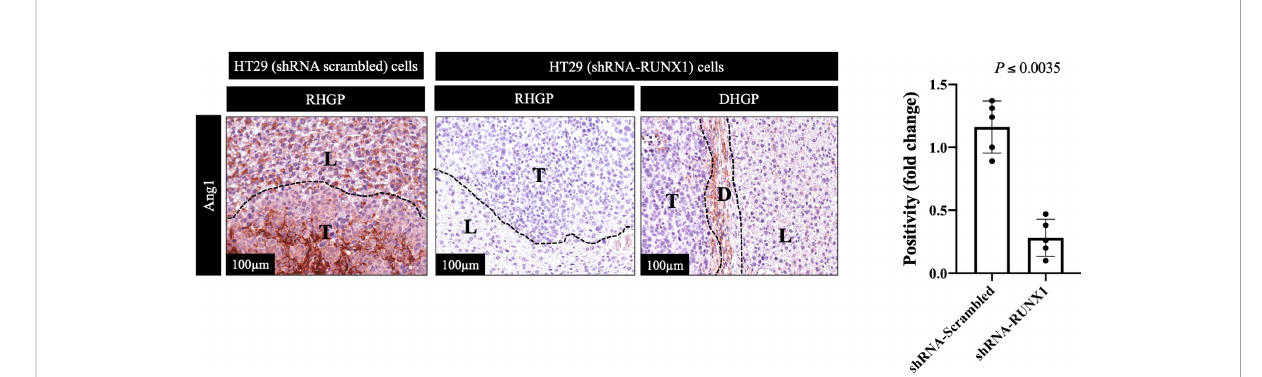
FIGURE 3 Knockdown of RUNX1 in the cancer cells attenuates the expression of Ang1 in liver parenchyma. The left panel represents immunohistochemical staining CRCLM sections generated from HT29 cancer cells expressing shRNA-Scrambled (n=5) or shRNA-RUNX1 (n=5) using anti-Ang1 antibody. The right panel shows the quanti fi cation of total positive staining that was assessed in CRCLM lesions using Aperio software. Relative expression levels of Ang1 were calculated by dividing the positivity value of each specimen from shRNA-Scrambled and shRNA-RUNX1 groups by the positivity value of specimen #1 from shRNA-Scrambled group and then presenting the result as a fold